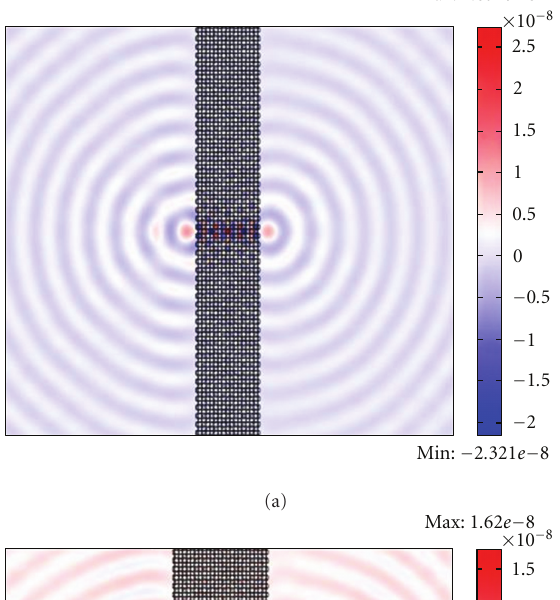
arrows stand for directions of phase velocity. The EFCs of the actual PhC are shown in Figure 2(b). AANR occurs at frequencies that correspond to all-convex contours with a negative photonic e ff ective mass. If the air-PhC interface normal is along the Γ -M direction, and the contour is everywhere convex, an incoming plane wave from air will couple to a single mode that propagates in this PhC on the negative side of the boundary normal.